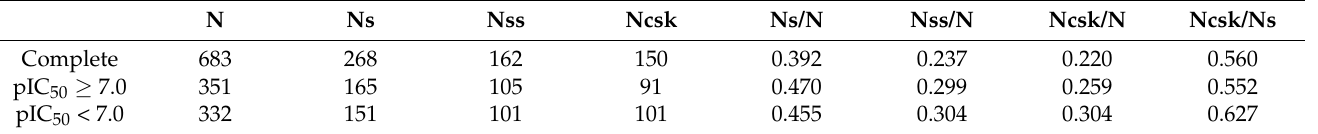
Table 4. Scaffold diversity analysis for nonsteroidal inhibitors. The number of total nonsteroidal compounds, the number of Murcko scaffolds, the number of singleton Murcko scaffolds, and the number of cyclic skeletons are denoted by N, Ns, Nss, and Ncsk,